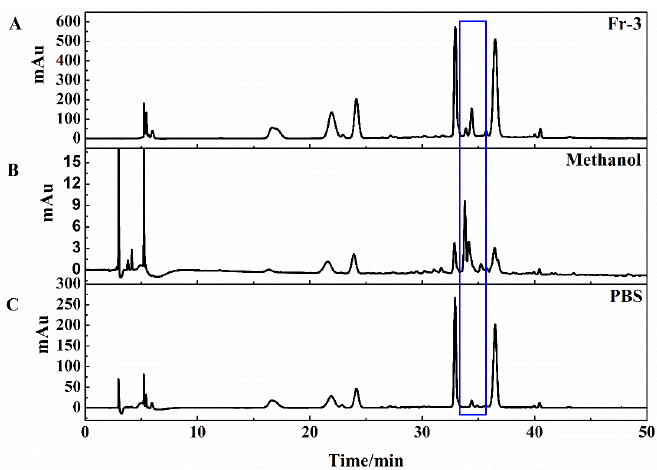
Figure 4. The HPLC analysis chromatogram of P.hookeri extract Fr-3 ( A ), methanol elution component ( B ) and PBS elution component ( C ) on the Odyssil C18 analytical column. Condition: mobile phase A: 0.2% v / v formic acid/water, B: ACN; gradient: 0–50 min, 5–35% B; monitoring wavelength: 254 nm; flow rate: 1.00 mL/min. The target fraction was framed by the blue